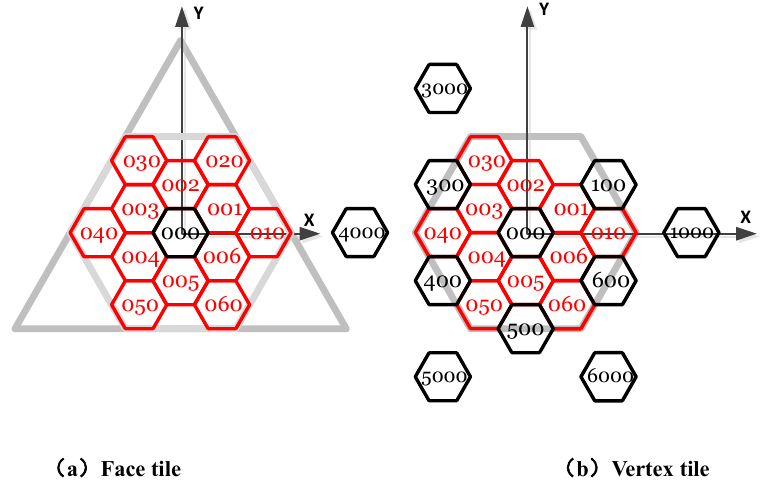
Figure 4. Codes and coordinate systems in Vertex tiles and face tiles